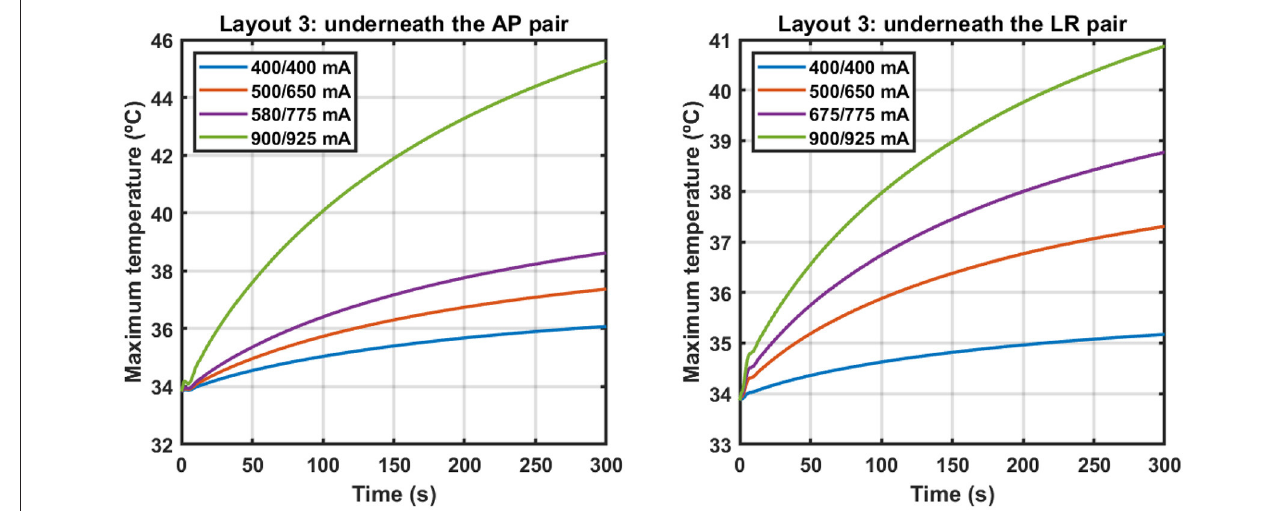
FIGURE 2 | Variation of the maximum temperature on the scalp underneath the AP ( left ) and LR ( right ) pairs when different sets of current were injected using layout 3. Each set is identified by a combination of two values, where the first one corresponds to the current injected into the AP pair and the second one to the current injected into the LR pair. Current was injected alternately with a switching time of one second. The y-axes are different for each plot.